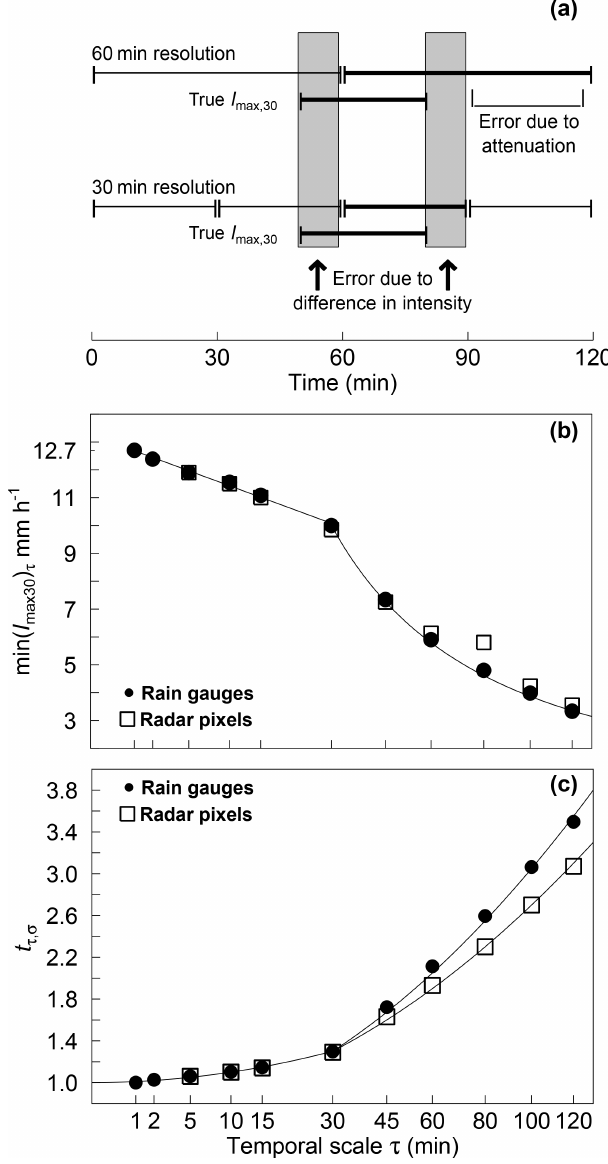
Figure 2. (a) Time periods influencing the underestimation of I max30 when temporal resolution is 30min (or higher) or when tem- poral resolution is 60min (or any resolution > 30min). (b) Mini- mum threshold for I max30 (min( I max30 ) τ ) derived from rain gauge (solid circles) and radar data (open squares) required to obtain the same number of erosive events as with a temporal resolution of 1min; lines show Eq. (6a) and (6b) (RMSE is 0.10 and 0.39). (c) Scaling factor t τ,σ to scale R e or R for temporal resolution τ when spatial resolution σ is either rain gauge scale (solid circles) or 1 × 1km 2 (open squares), respectively; lines show Eq. (7a), (7b) and (7c) (for all RMSE ≤ 0 . 04). The x axes in (b) and (c) are square-